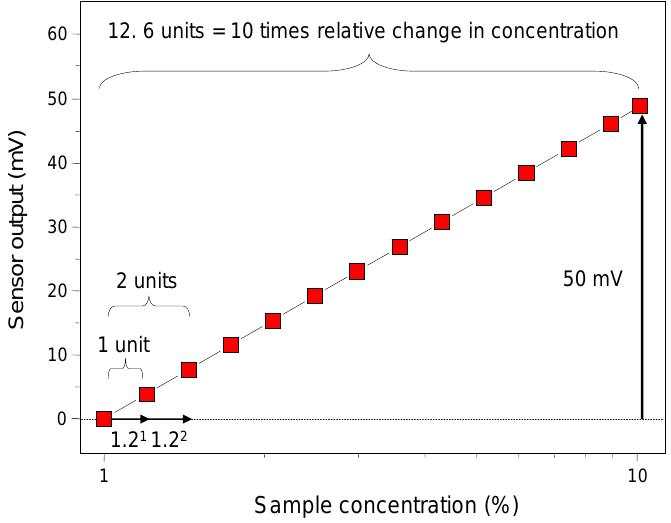
Figure 13. Example of conversion factor calculation for a taste sensor with slope of 50 mV/decade for some taste